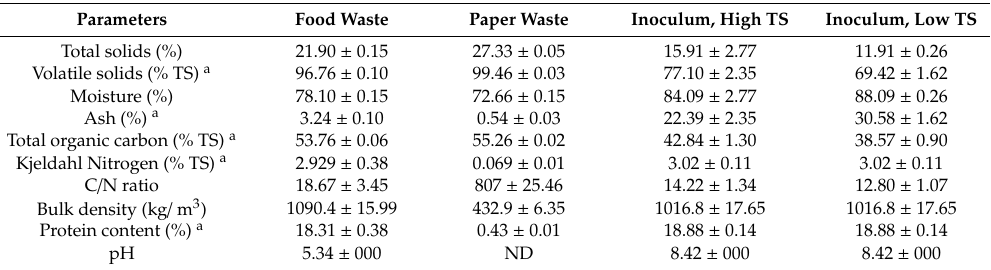
Table 1. Characteristics of Substrate and Inoculum used for the dry AD experimental setup.